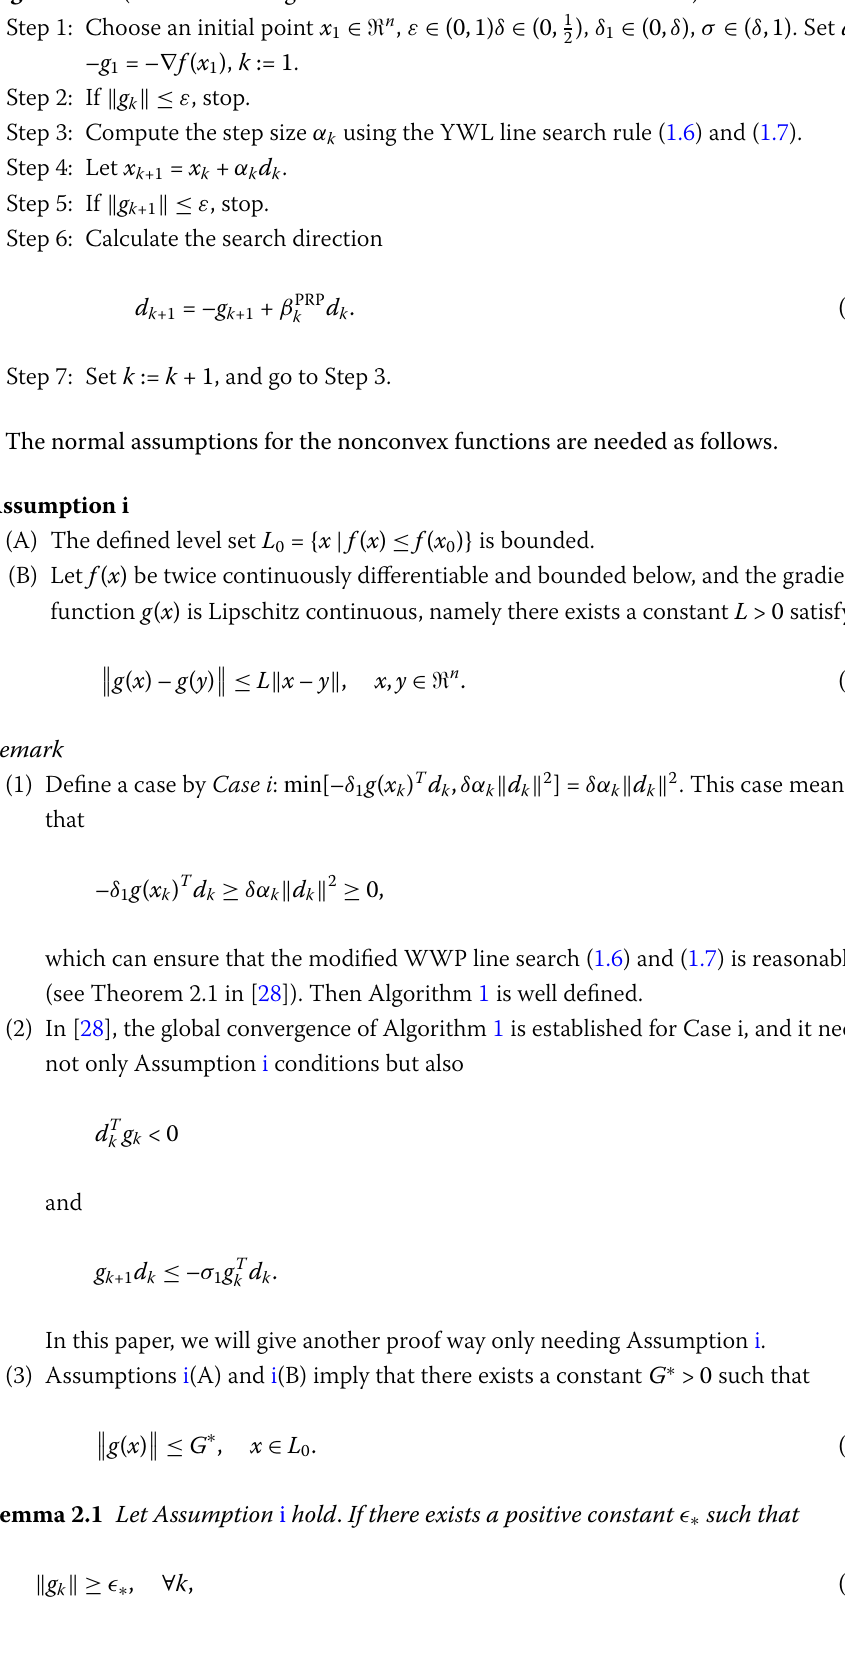
Algorithm 1 (The PRP CG algorithm under the YWL line search